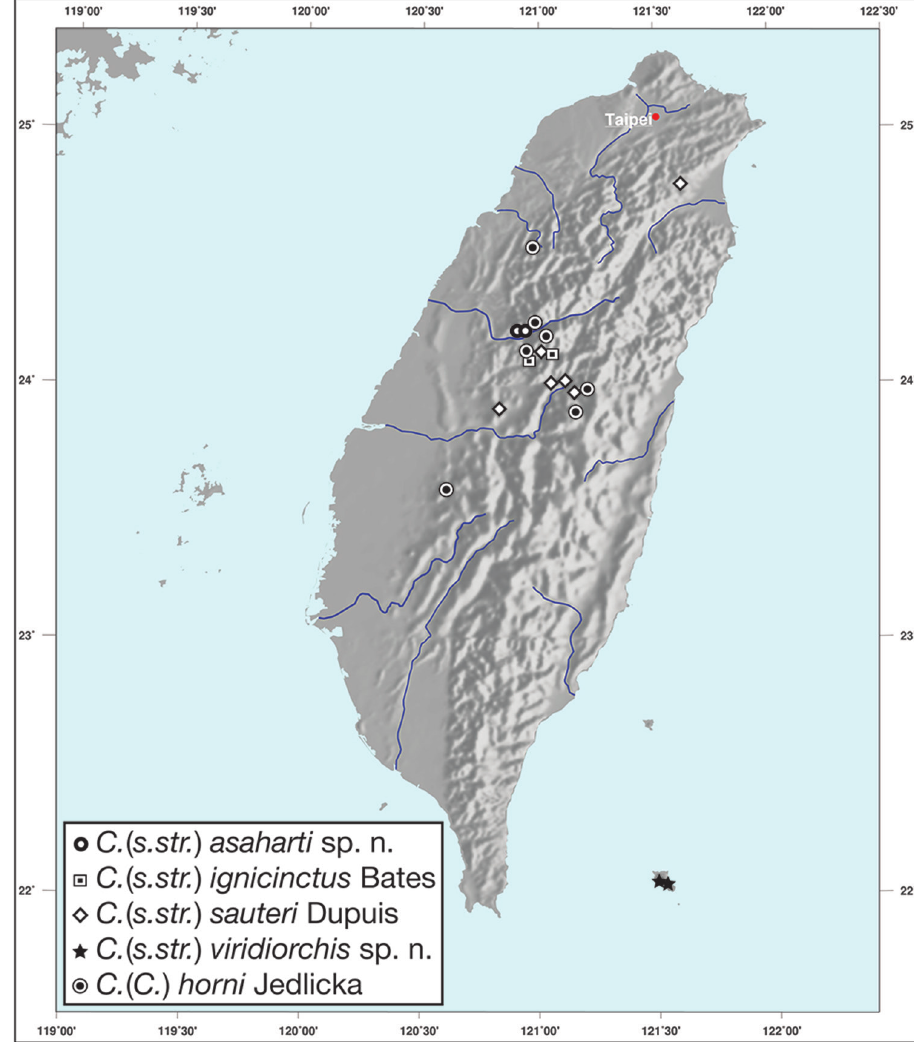
Figure 35. Map showing known localities for species of the genus Catascopus Kirby and subgenus Catascopoides Habu, in